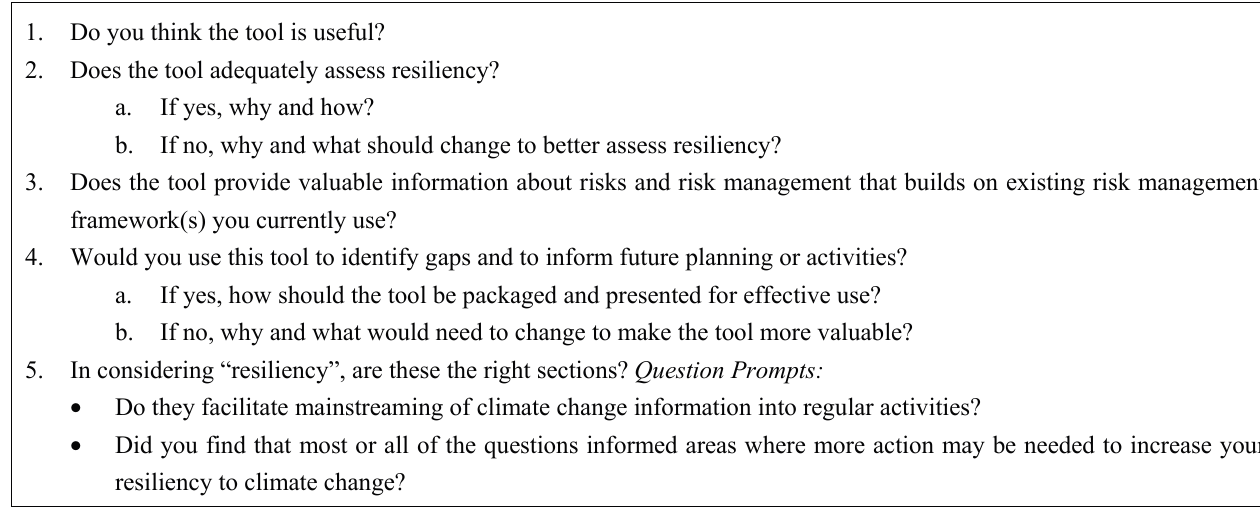
Table 2. Interview questions to pilot health care facility